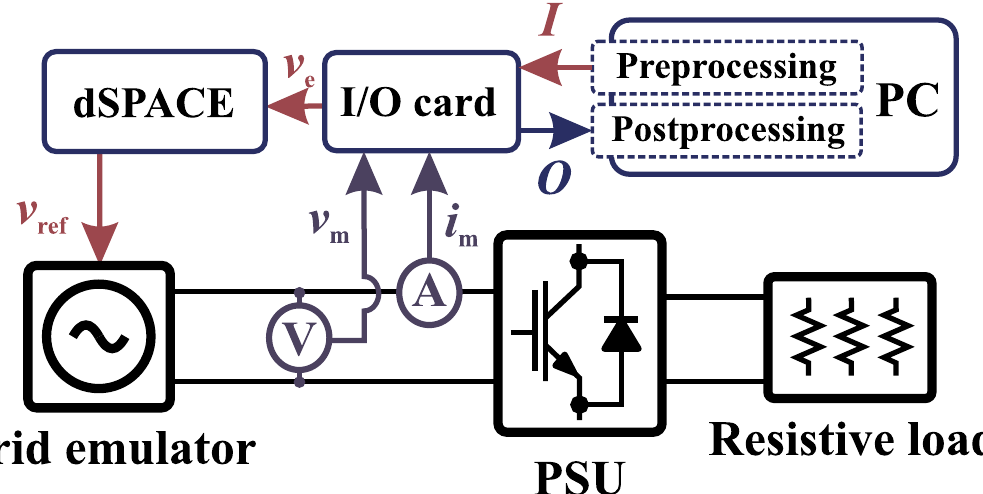
Figure 7. Schematic diagram of the experimental measurement setup.